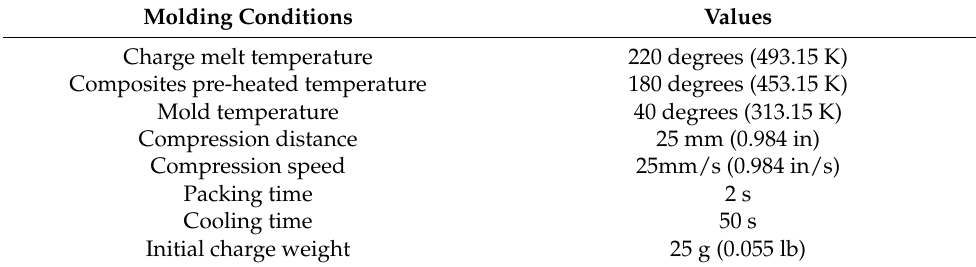
Figure 9. The validation mold: ( a ) open state, ( b ) initial closure, ( c ) mold. Table 3. Molding